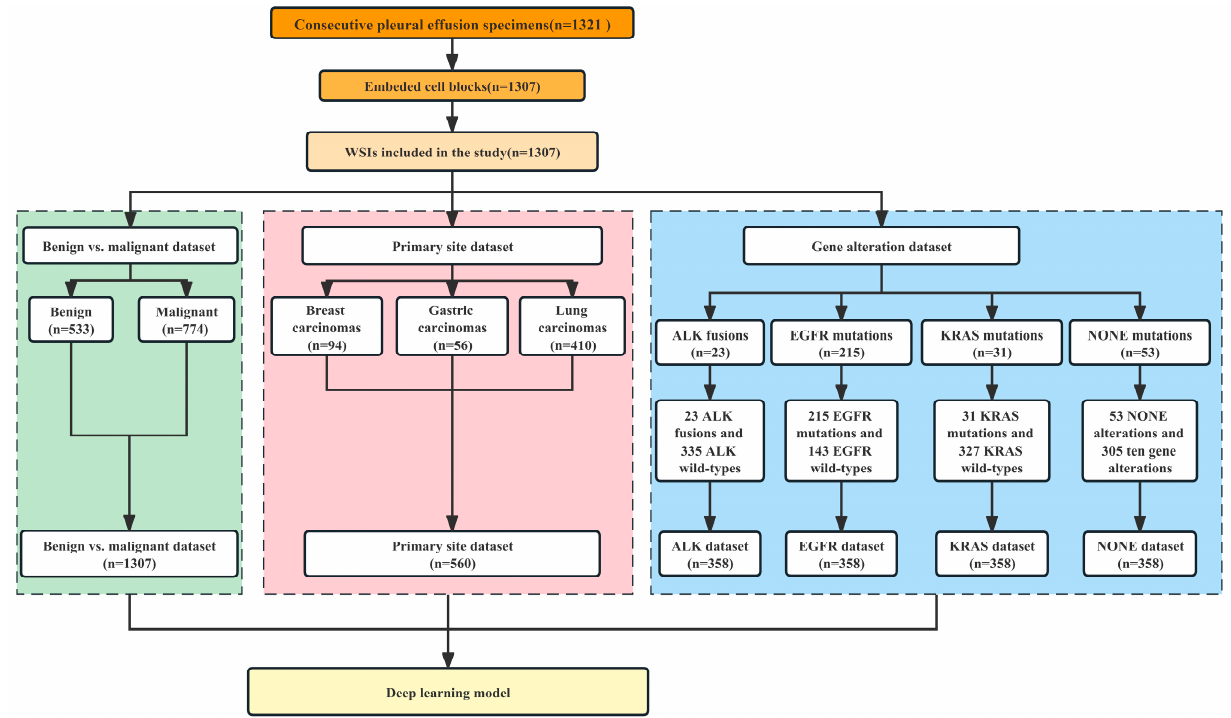
Figure 1. Case screening and establishment of datasets for three